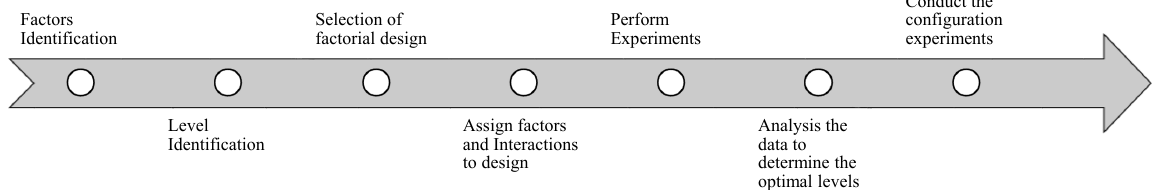
Figure 11. Steps in implementation of DOE approach. Reprinted with permission from ref. [2]. Copyright 2021 Springer.